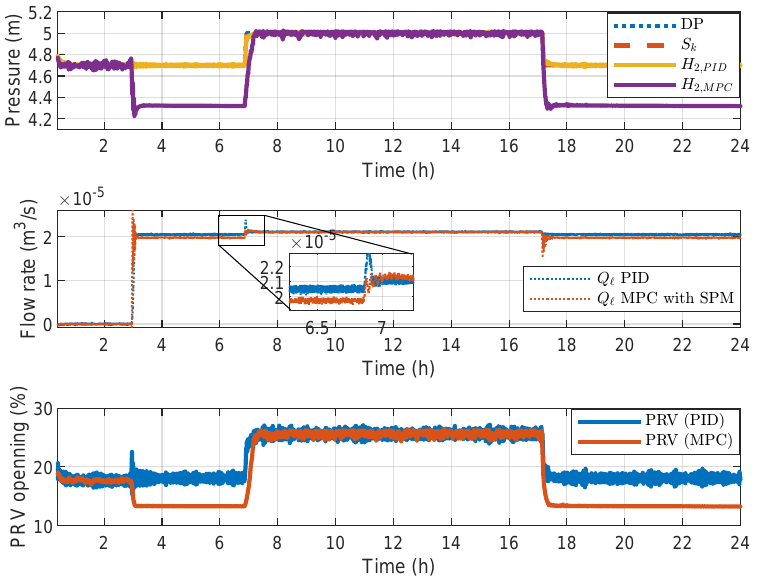
Figure 9. Case 2: Comparison between a traditional PID controller and the proposed control